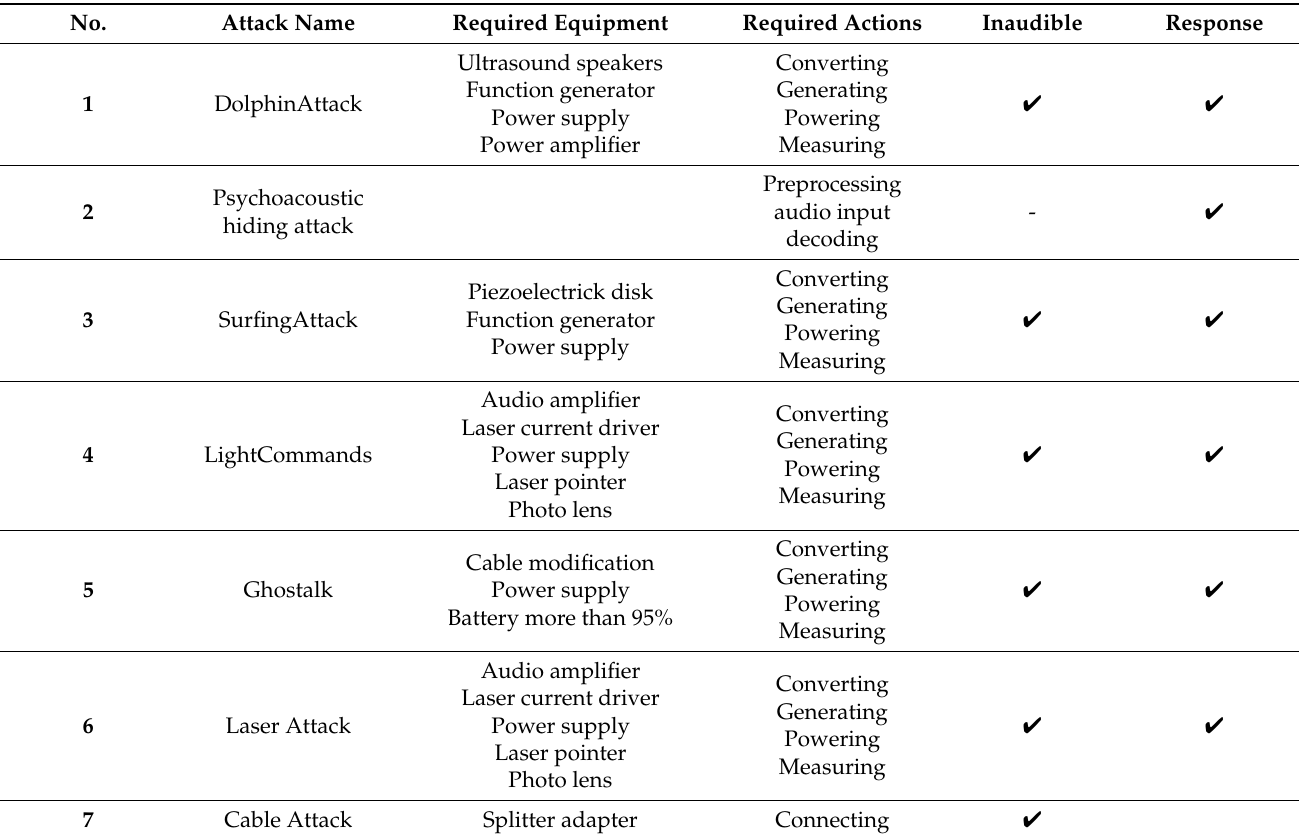
Table 8. Common characteristics of the most